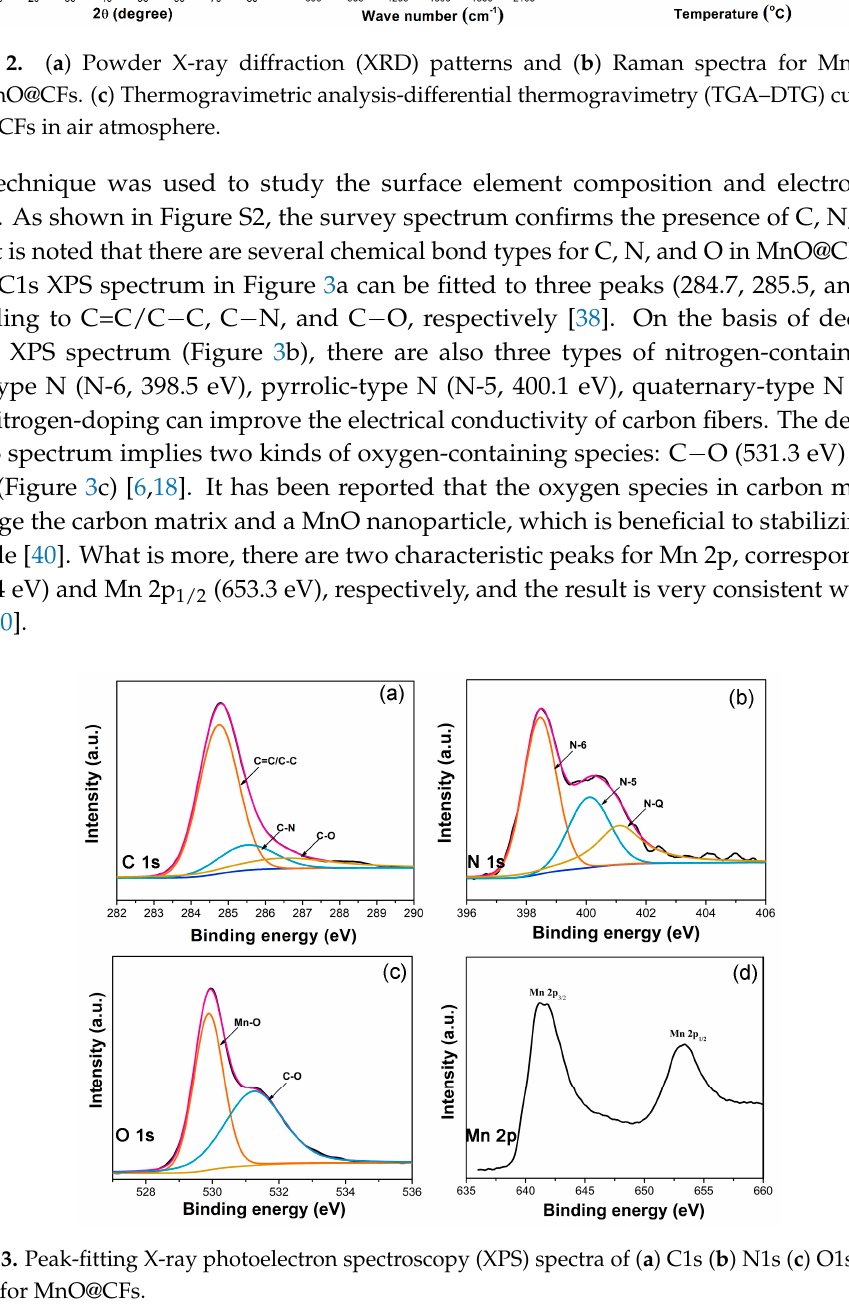
Figure 2. ( a ) Powder X-ray diffraction (XRD) patterns and ( b ) Raman spectra for MnO, CFs, and